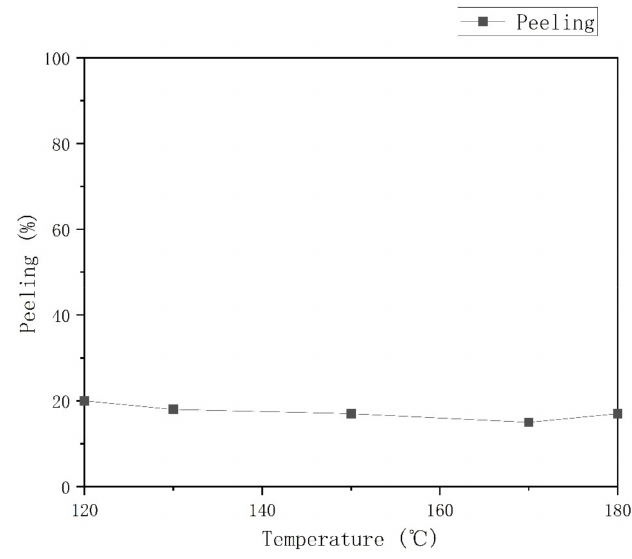
Figure 5. Peeling test results with Different Temperatures.